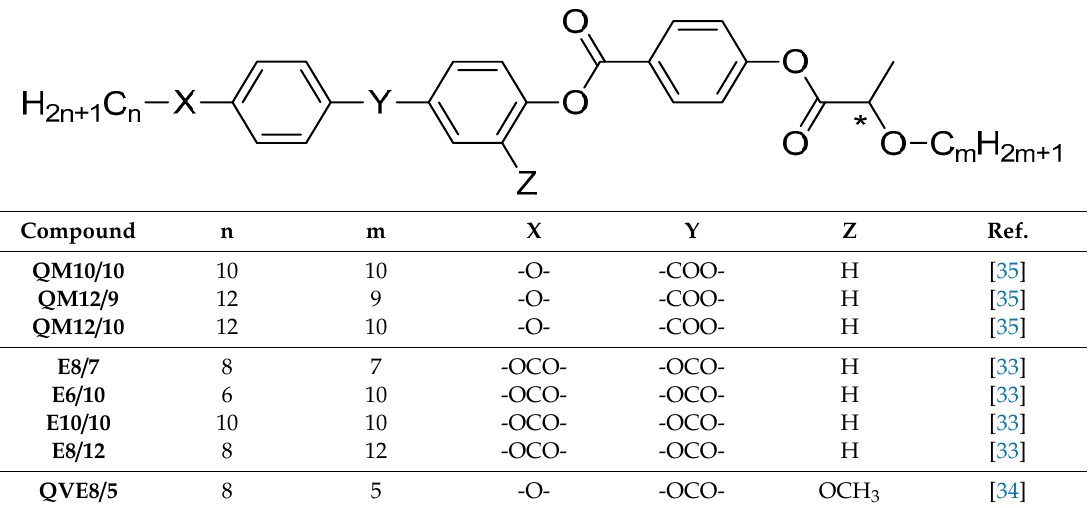
Table 1. General structure of the investigated compounds.